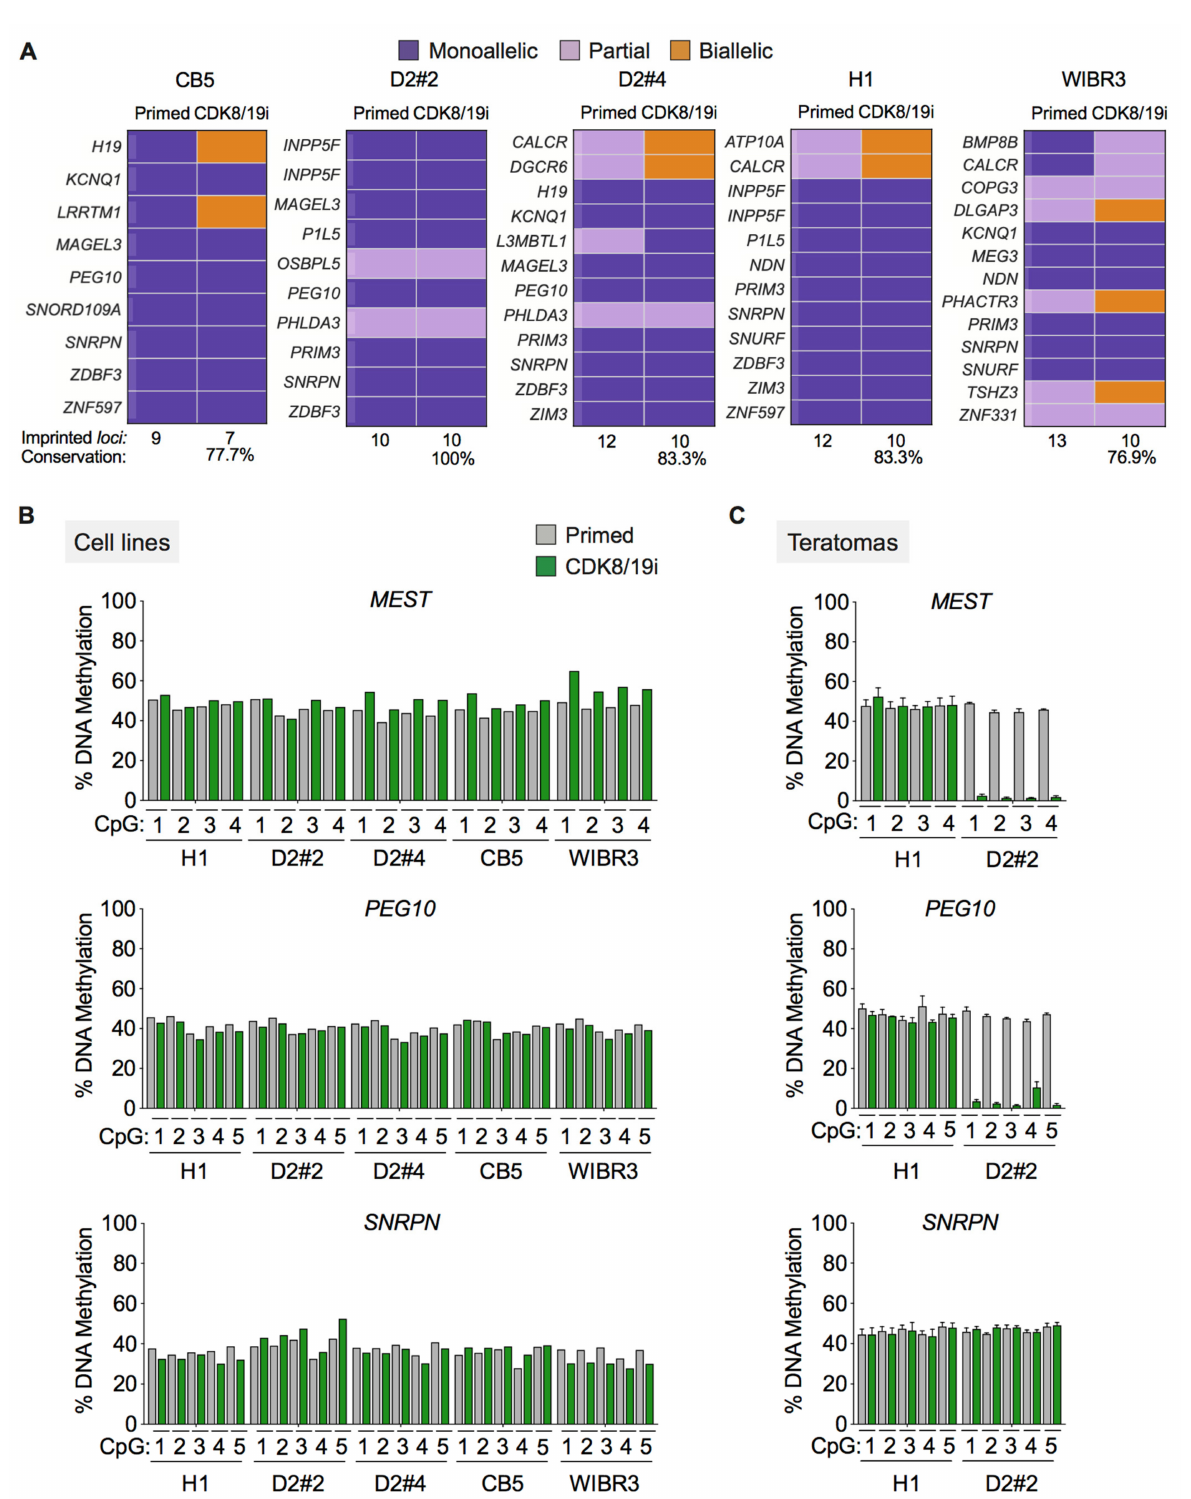
Figure 2. Long-term cultured CDK8/19i-naïve hPSCs retain monoallelic expression and hemi-methylation at imprinted loci . ( A ) Heatmaps of allele specific expression data for the indicated informative imprinted genes in primed versus CDK8/19i long-term cultured hPSCs. The lower part of each panel indicates the number and percentage of genes expressed in a monoallelic or partially monoallelic manner after long-term culture in the presence of CDK8/19i. ( B ) CpG methylation status of differentially methylated regions (DMRs) at the indicated imprinted loci in five hPSC lines adapted to CDK8/19i for >10 passages. For each DMR, a total of 4 or 5 individual CpGs were analyzed by pyrosequencing. ( C ) CpG methylation status of DMRs in teratomas obtained from primed hPSCs or long-term adapted to